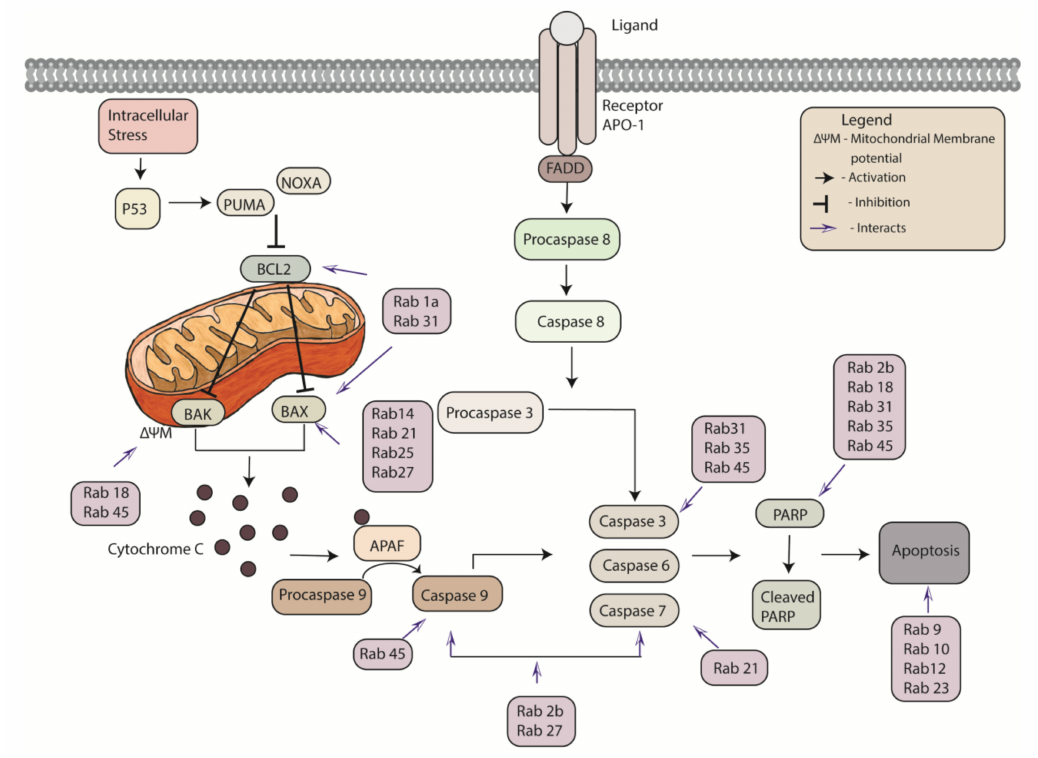
Figure 4. Apoptotic signaling pathways with the reported interaction of Rab proteins. The intrinsic (mitochondrial) pathway is initiated by an internal stress and triggers the induction of apoptotic B cell lymphoma protein 2 (BCL-2) proteins. The BCL-2 family consists of pro-apoptotic BCL-2 homologous antagonist killer (BAK), BCL-2 associated X protein (BAX) and anti-apoptotic BCL-2. Mitochondrial membrane potential ( ∆Ψ M) releases apoptotic proteins into the cytosol. Cytochrome c forms an apoptosome with apoptotic protease-activating factor-1 (APAF-1) converting procaspase-9 into caspase 9. In the extrinsic pathway an external stimulus activates cell surface receptors such as apoptosis antigen-1 (APO-1). The activation enables the recruitment of the adapter protein, Fas-associated protein with death domain (FADD) and activates procaspase 8. Both pathways lead to the activation of execution cysteinyl aspartic acid-proteases (caspases) including initiator caspases (2,8,9,10) and executioner caspases (3,6,7). Initiator caspases bind to proteins such as FADD and APAF-1. Executioner caspases activate cytoplasmic endonuclease and proteases and cleave various substrates such as poly (ADP-ribose) polymerase